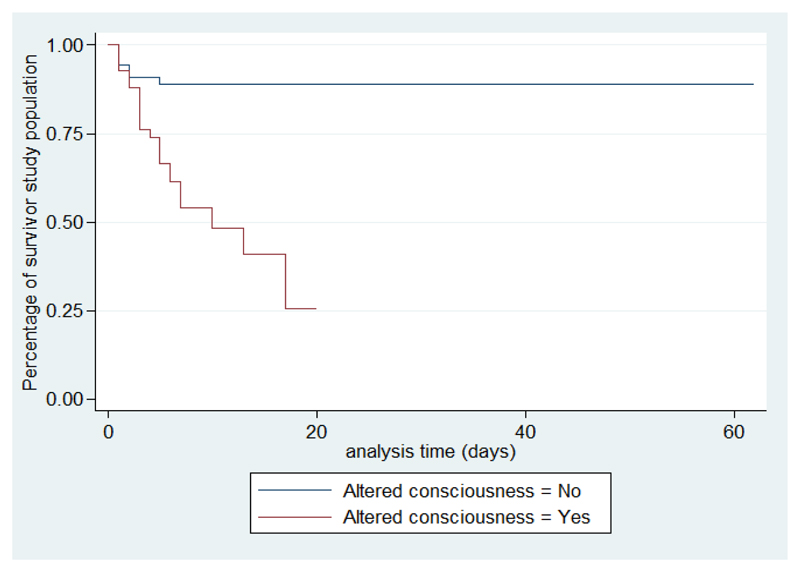
Survival analysis curves according to altered consciousness